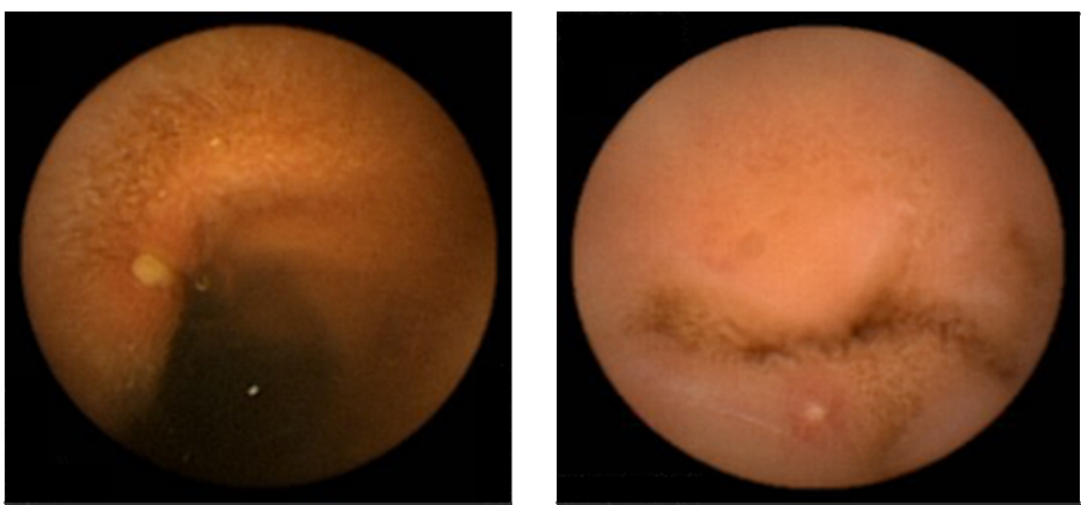
Figure 4. Example of typical mucosal breaks found in the